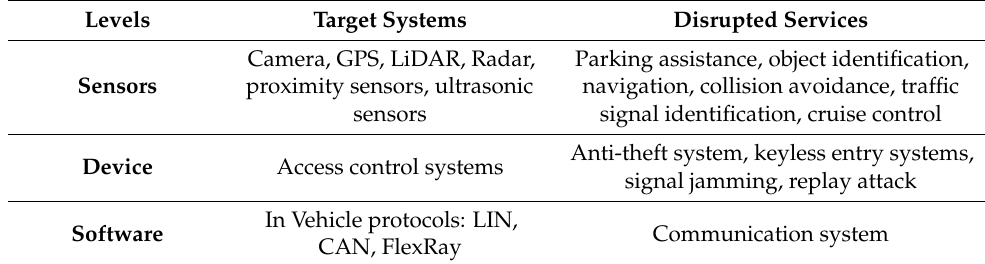
Table 4. Vulnerabilities in Autonomous Vehicles